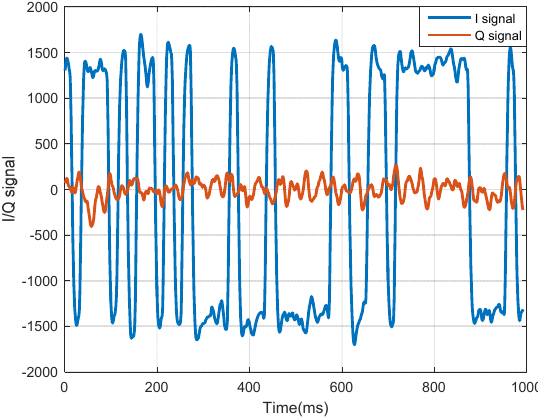
Figure 5. Coherent-accumulation measurement (I/Q) signals of GPS L1 from a stable tracking loop. Sensors 2020 , 20 , x FOR PEER REVIEW